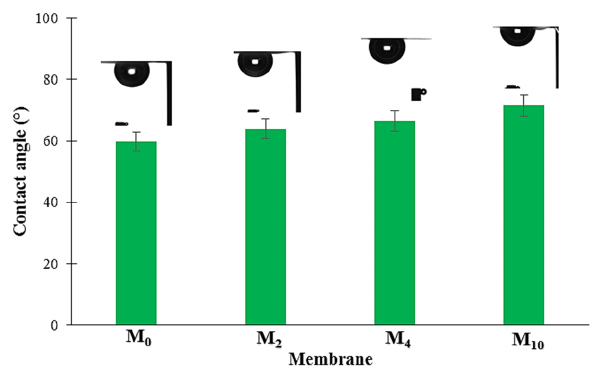
Figure 7. The contact angle of the PA6 membranes measured by captive bubble